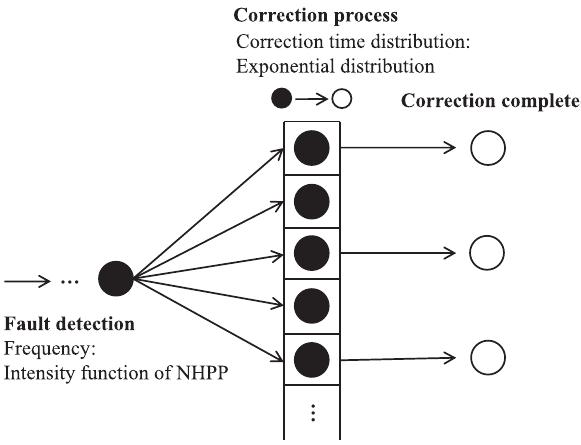
Figure 6. Conceptual figure of the infinite server queuing